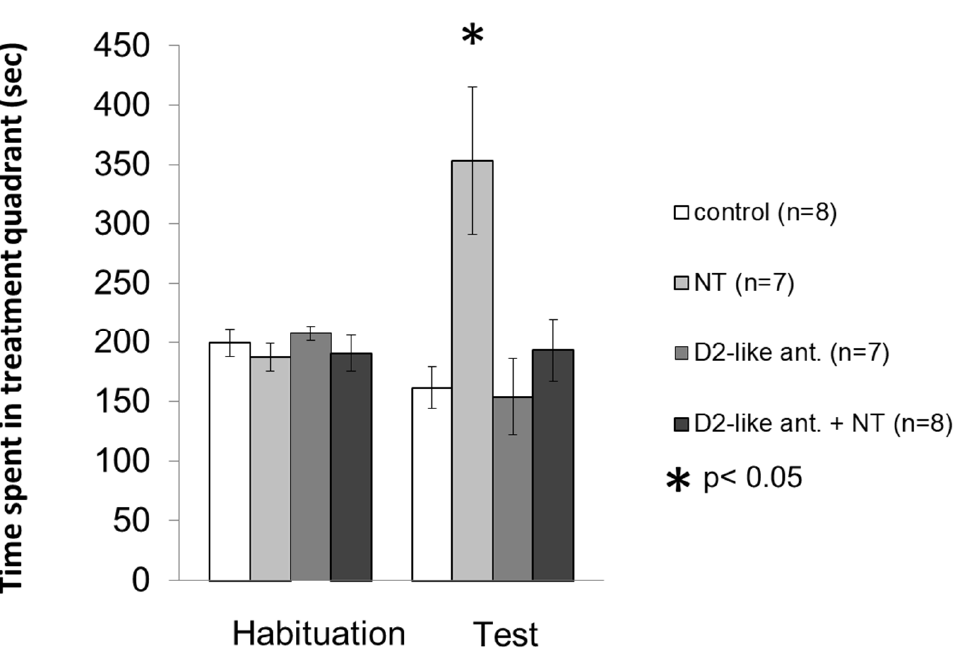
Figure 3. Effects of D2-like DA receptor antagonist sulpiride pretreatment on the NT induced con- ditioned place preference in the VP. Columns represent mean time spent in the treatment quadrant (±S.E.M.) during Habituation and Test trials, respectively. Control group: rats received two mi- croinjections of vehicle (n = 8). NT group: animals microinjected with vehicle + 100 ng NT (n = 7). D2-like ant. group: animals received 4 μ g D2-like DA receptor antagonist sulpiride + vehic1e (n = 7). D2-like ant. + NT group: effect of microinjections of 100 ng NT after 4 μ g sulpiride pretreatment (n = 8). For further explanation, refer to the text. *: p < 0.05.